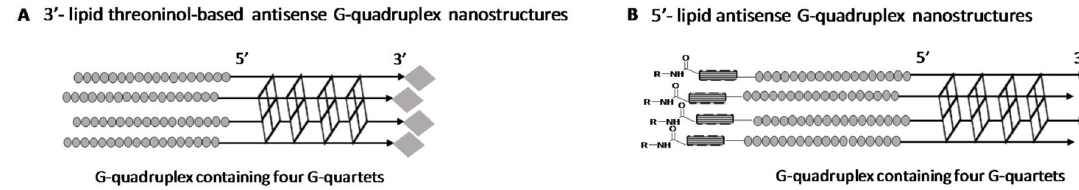
Figure 4. G-quadruplex forming oligonucleotide conjugates prepared in this study. ( A ). Lipid threoninol-based modifi- cations were introduced at the 3 ′ -termini of the G-rich sequence and ( B ). Lipid amino lipids were introduced, modifying the 5 ′ -terimni of the G-rich sequence.